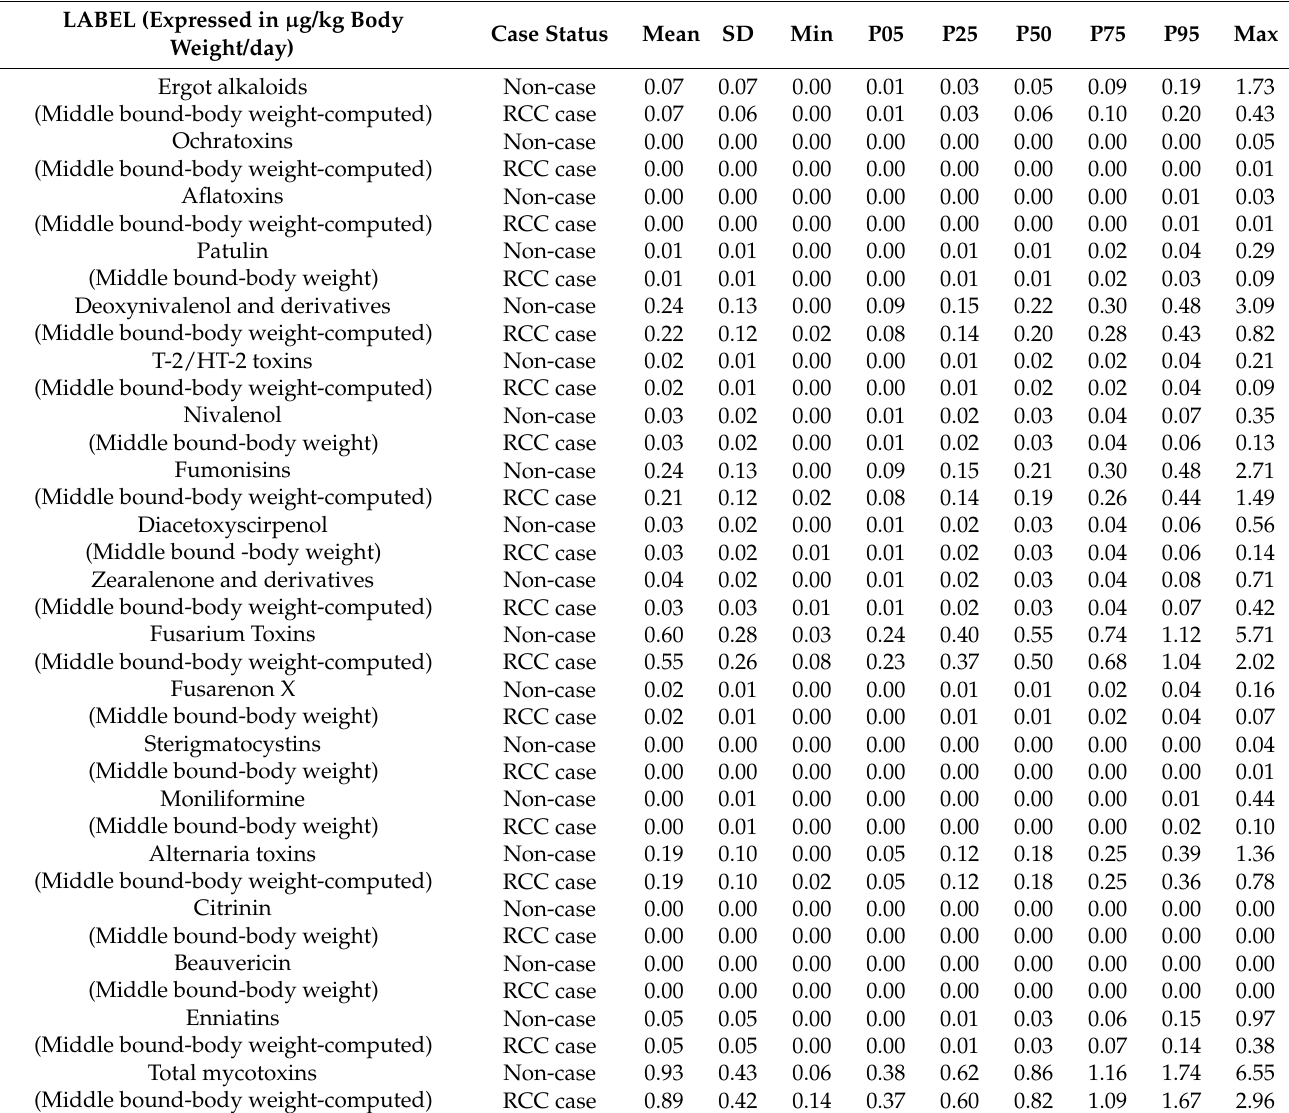
Table 2. Description of the external mycotoxin exposures assessed on the basis of dietary question- naire data for the EPIC cohort. Table S1 shows the lower bound (LB) values, and Table S2 shows data relative to EFSA reference